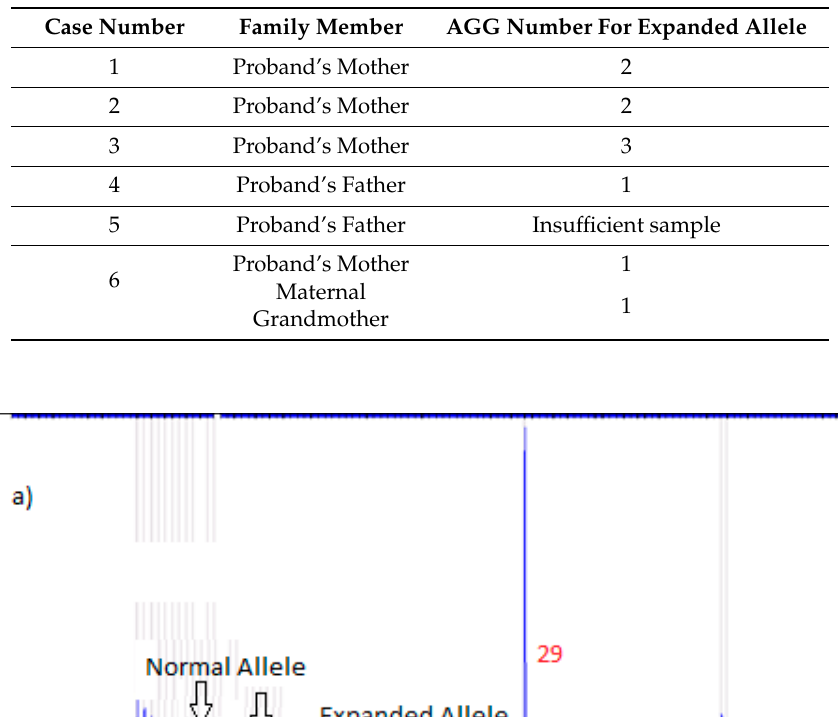
Table 4. Family studies—AGG interrupt data.